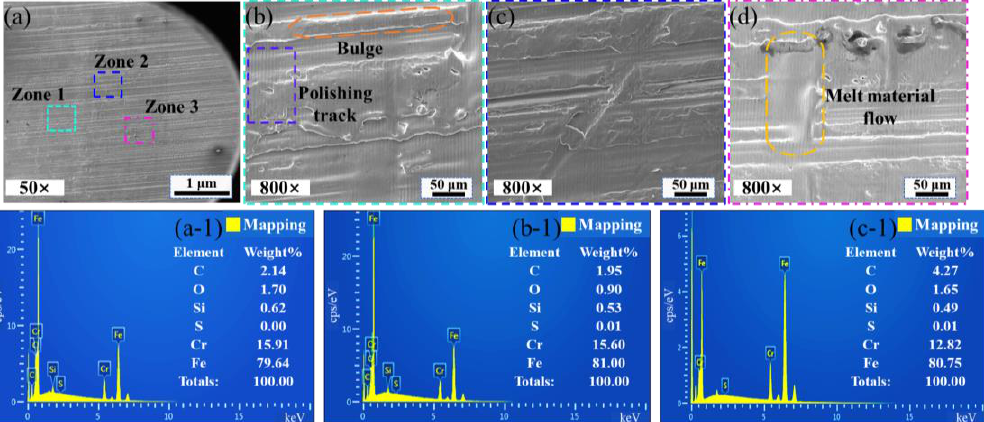
Figure 12. SEM morphologies and element content of polished surfaces with scanning speed of 250 mm/min. ( a ) The polished surface of 50 × magnifications; ( b ) Surface morphology of Zone 1; ( c ) Surface morphology of Zone 2; ( d ) Surface morphology of Zone 3; ( a - 1 ) Surface element content on Zone 1; ( b - 1 ) Surface element content on Zone 2; ( c - 1 ) Surface element content on Zone 3.